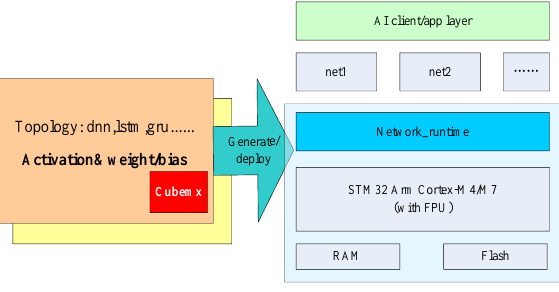
Figure 5 . Neural network transplantation